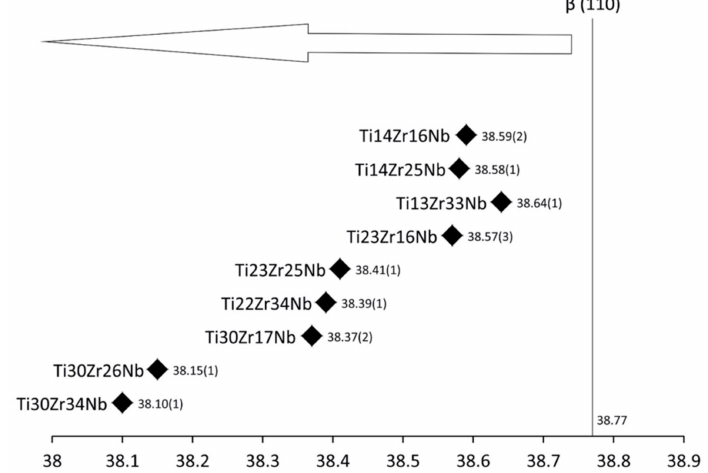
Figure 2. New phase Ti( β ) 2 theta locations of studied alloys after 6 h of